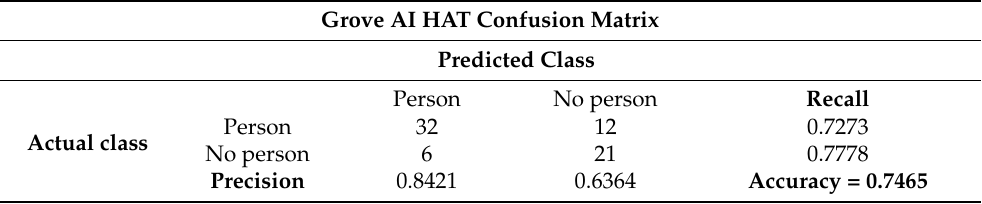
Table 7. Accuracy of the person detector with Grove AI HAT.